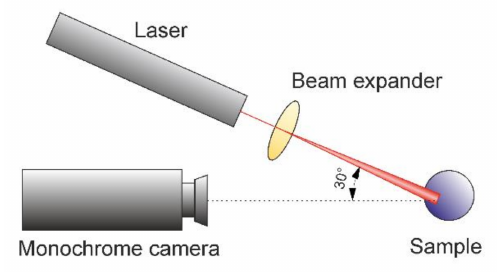
Figure 3. Scheme of biospeckle imaging